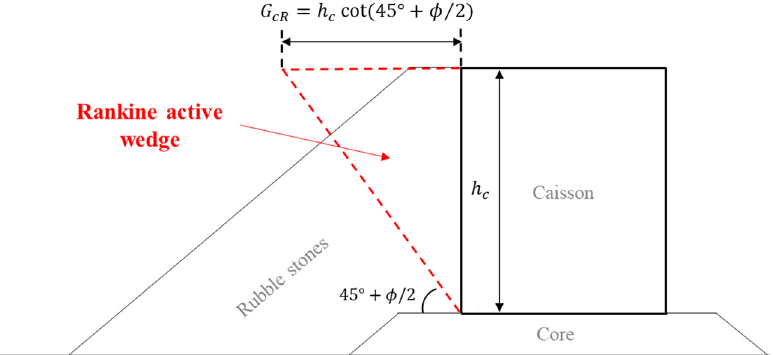
Figure 3. A schematic diagram of a caisson whose front face is covered with rubble stones of nar- rower width than Rankine’s active wedge.